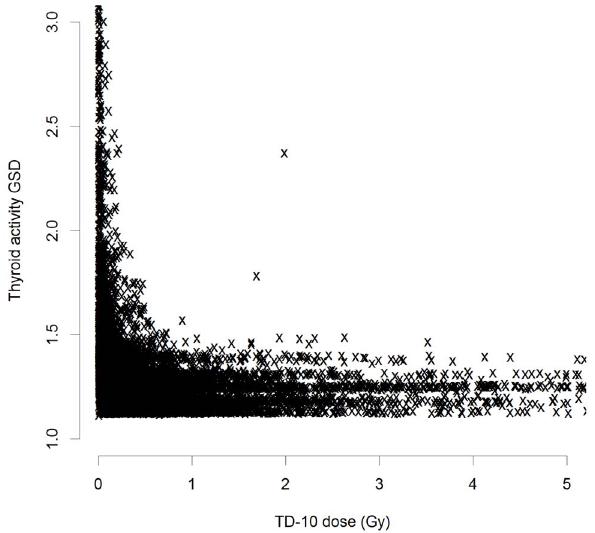
Figure 3. Distribution of the geometric standard deviation (GSD) of errors associated with assessments of thyroid mass GSD as a function of TD-10 thyroid dose.